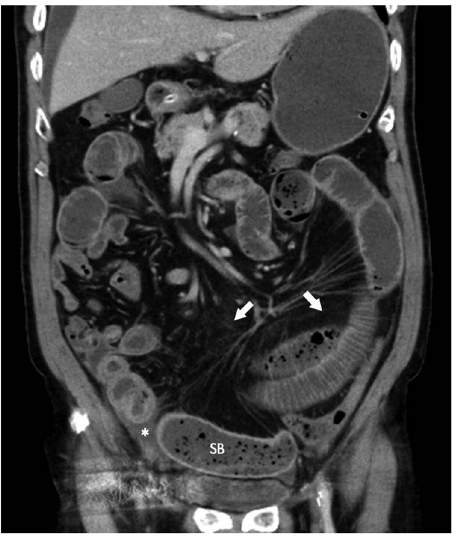
Figure 2. Small bowel faeces sign. Coronal MDCT image shows faeces-like material mixed with gas bubbles and fluid at the distal small bowel (SB). The finding is frequently seen proximal to the site of obstruction. Mesenteric fatty infiltration (arrows) and small amount of